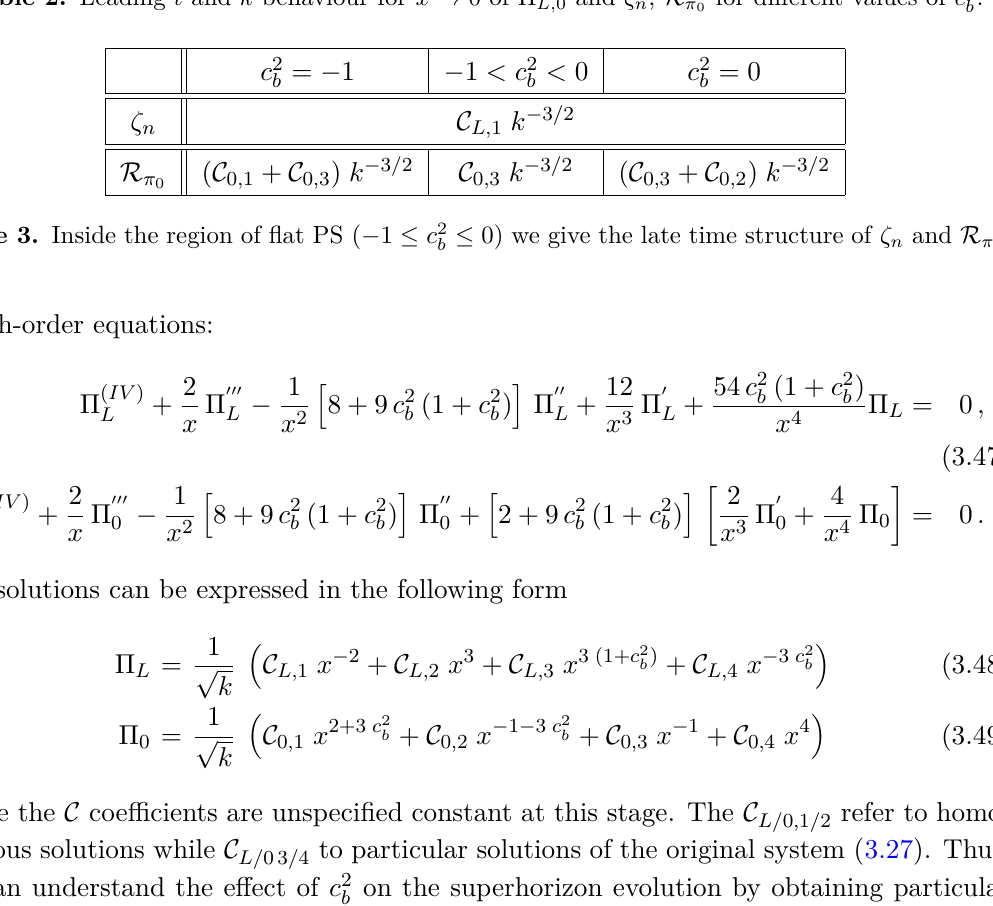
Table 2. Leading t and k behaviour for x → 0 of Π L, 0 and ζ n , R π